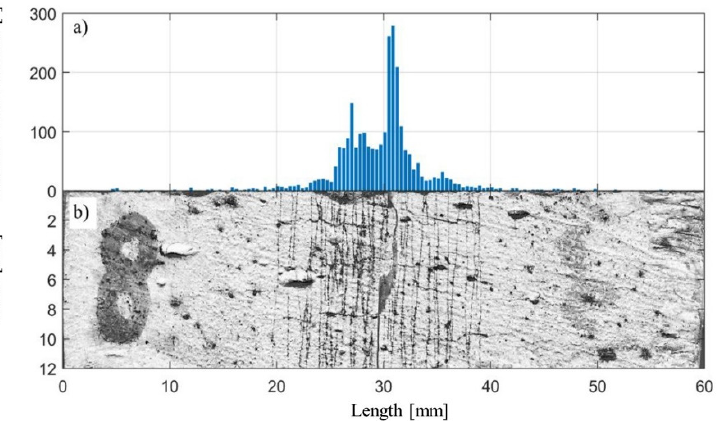
Figure 10. ( a ) Histogram with spatial distribution of the AE events along with the specimen; the y- axis indicates the number of AE events over the length of the specimen, and the width of the individual bins correspond to 0.38 mm; the x-axis corresponds to the length of the specimen; ( b ) shows the crack pattern visible by dye penetrant inspection on the specimen’s bottom.